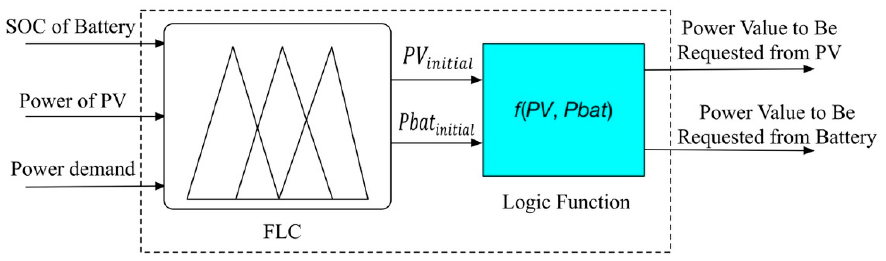
Figure 10. A schematic diagram of Fuzzy logic energy management strategy.